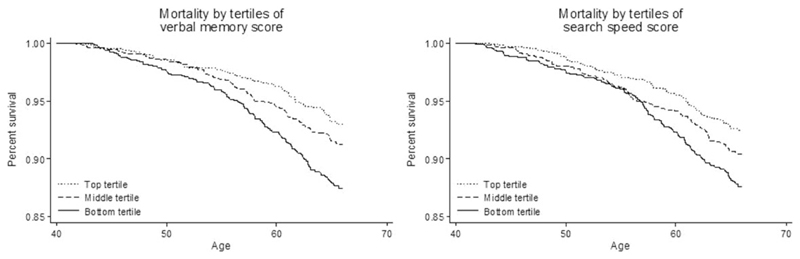
Kaplan-Meier survival curves describing unadjusted mortality from age 43 onwards in respect to tertiles of cognitive performance. Left panel: verbal memory; right panel: search speed. Note y-axis originates at 0.85.